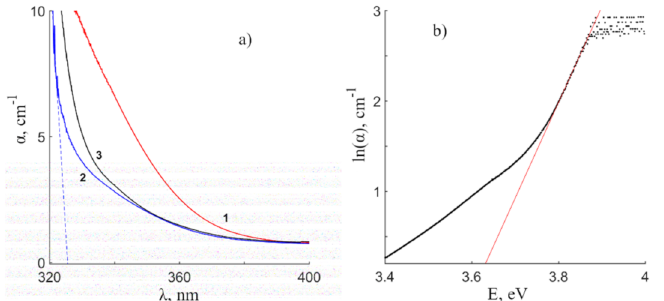
Figure 1. ( a )—Optical absorption spectra of crystals: SLN (1), SLN (6.0 wt% K 2 O) (2), CLN (3). ( b )—Dependence of ln( α ) on E for calculating the Urbach energy of the CLN crystal. Figure 1a demonstrates that the absorption spectra of the CLN and SLN (6.0 wt% K 2 O) crystals are quite similar. However, SLN (6.0 wt% K 2 O) spectrum is shifted